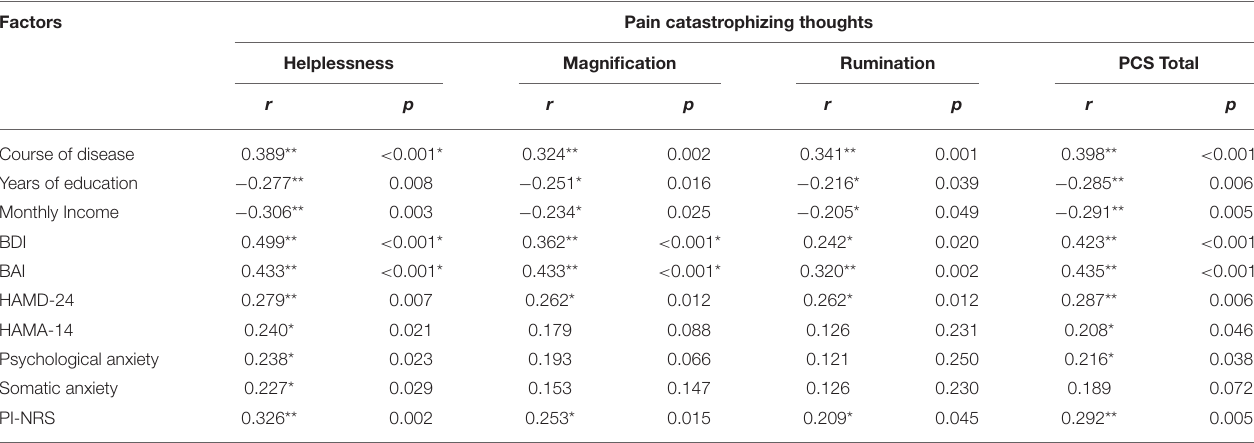
TABLE 4 | Factors correlation with pain catastrophizing thoughts.